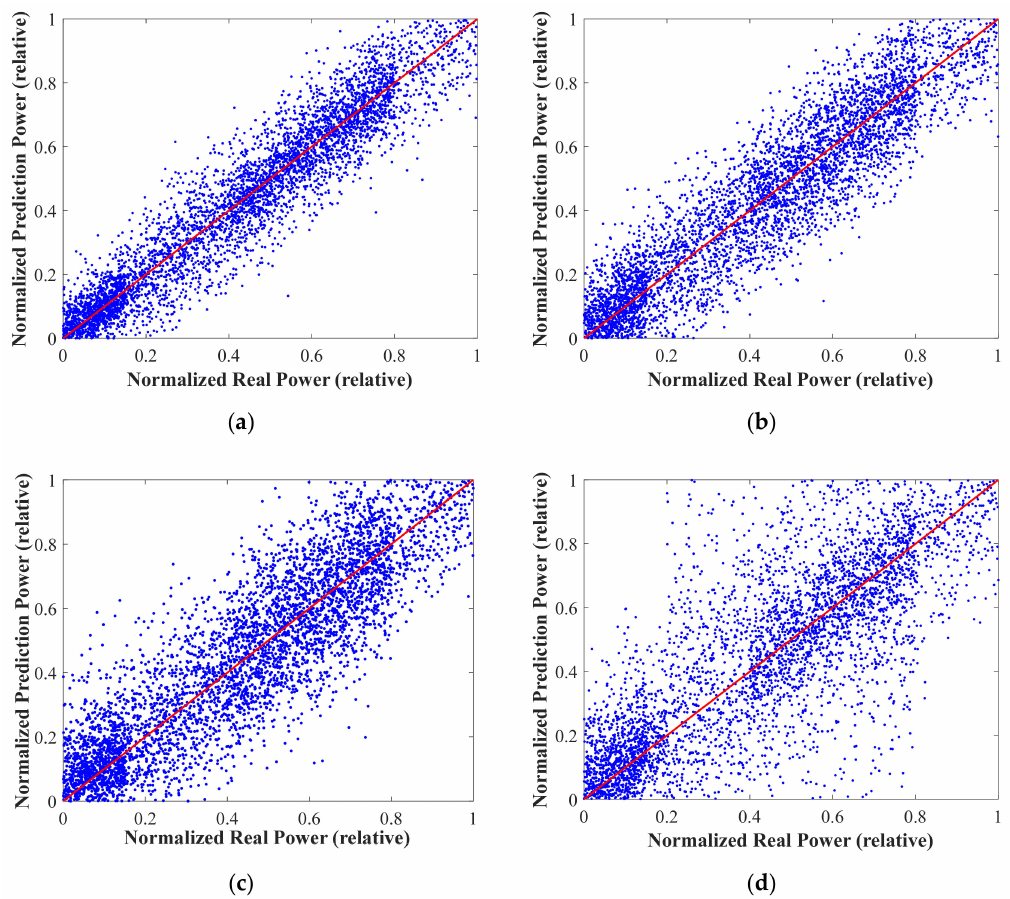
Figure 13. The real measured power versus prediction power on regional output: ( a ) using the proposed method; ( b ) using the NWP (Numerical weather prediction) model; ( c ) using the support vector machine (SVM) model; ( d ) using the persistence